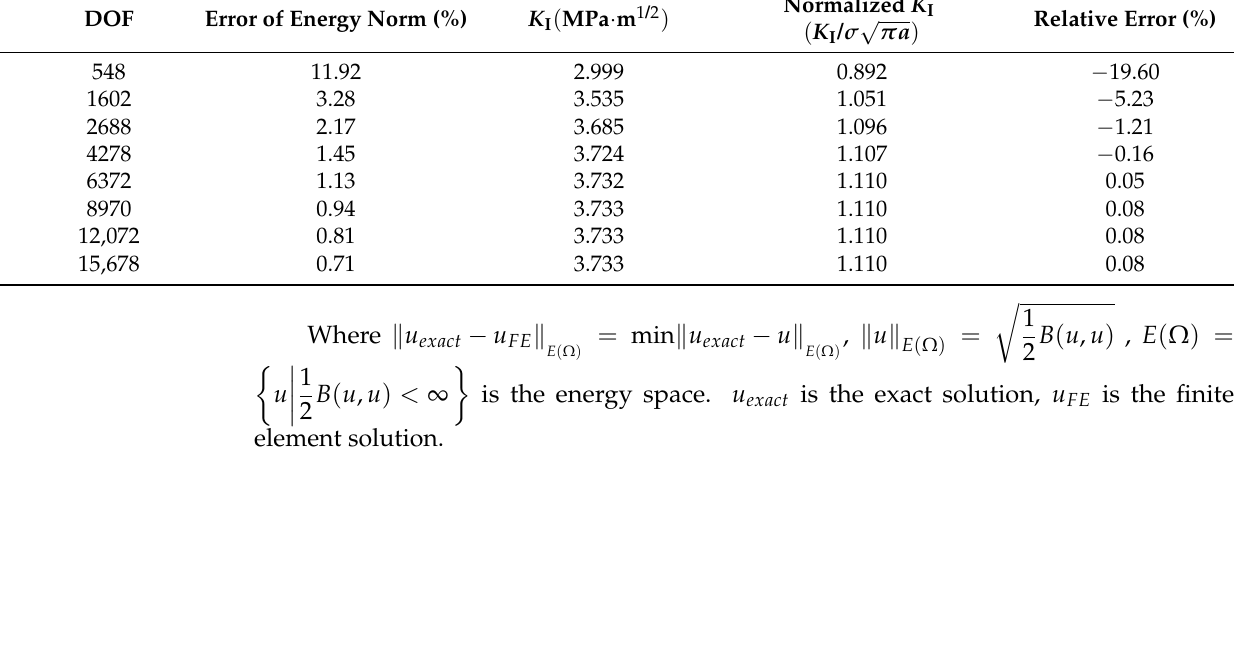
( a/W = 0.4, Ι Normalized K I √ ( K π a I / σ